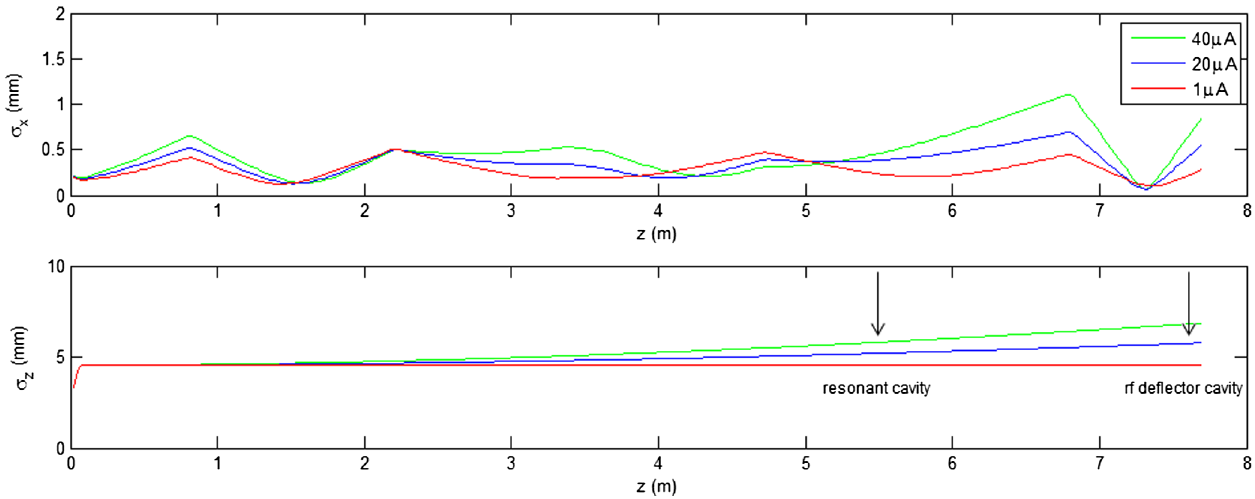
FIG. 6. Simulation results showing the transverse (top) and longitudinal (bottom) rms sizes the beam as a function of distance from the photocathode for various beam currents using the laser at 249.5 MHz. The arrows denote the locations of the harmonically resonant cavity and the narrow aperture between the two RF-deflecting